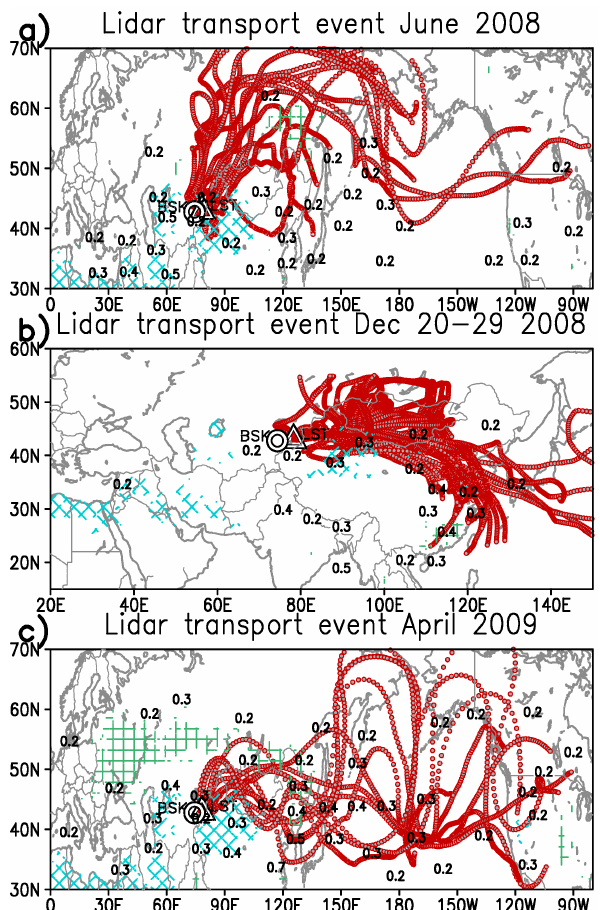
Figure 16. Ten-day air mass forward trajectories illustrating the seasonality in transport pathways out of CA for (a) June 2008, (b) December 2008, and (c) April 2009. The blue diamond and green square hatched areas denote the natural dust and biomass burning emission sources, respectively, while the numbers in black denote MODIS AOD contours averaged over the event time period and sub- sequent 10-day time window. “Lidar” denotes the LST